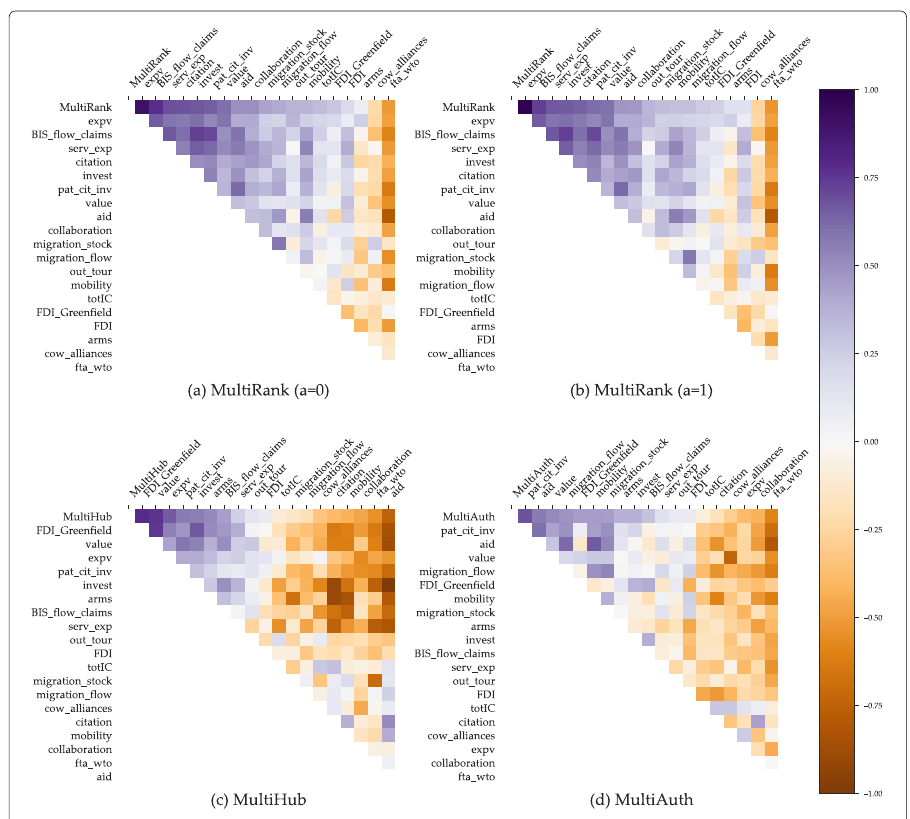
Fig. 22 Spearman correlation of the node rankings obtained by calculating centrality measures on both the single layers and the multiplex (hence using the multiplex version of the algorithms). For the MultiRank rankings the other parameters are in both cases s = 1 and γ = 1. All results refer to the cross section in